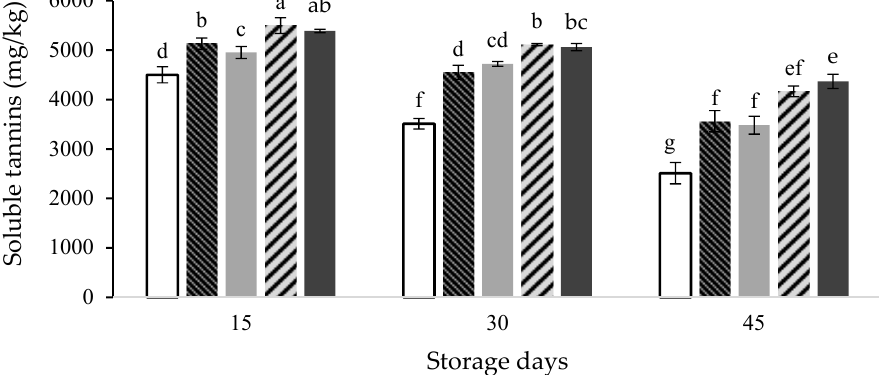
Figure 5. Effects of chitosan, phenylalanine, and chitosan-coated phenylalanine nanoparticles treatments on the soluble tannins content of persimmon fruit during storage at 4 °C for 15, 30, and 45 days. Each value represents the mean ± standard errors of three replications. Different letters indicate statistical differences using Duncan’s multiple range tests at P < 0.05 level.